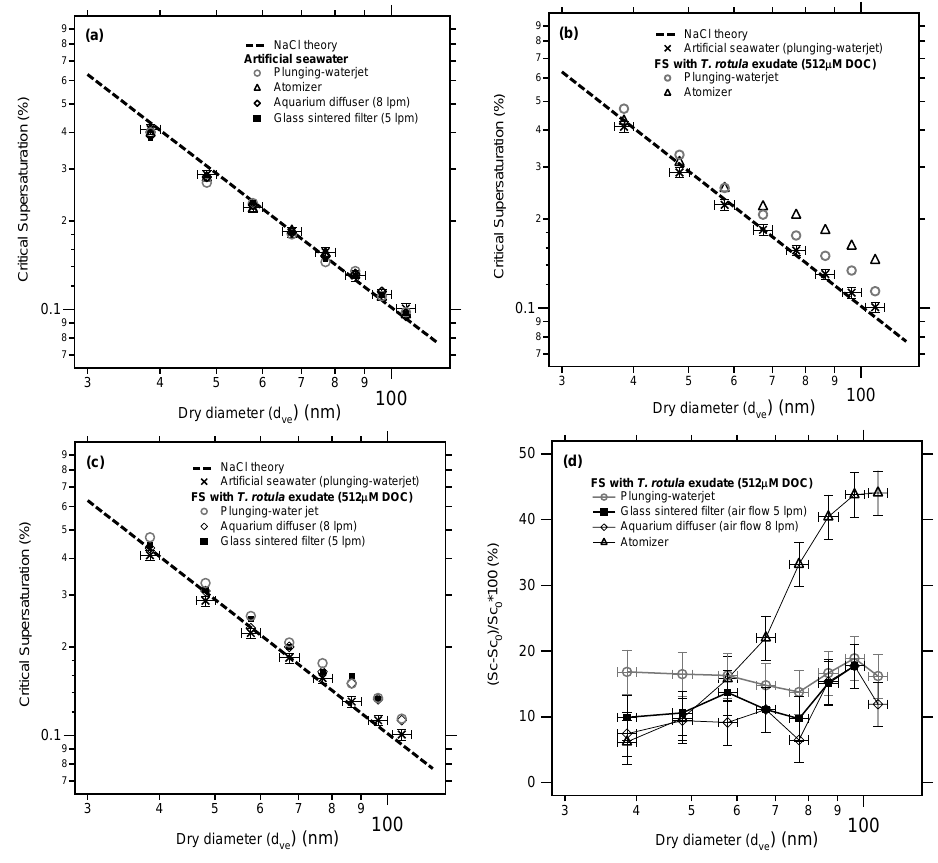
Fig. 9. Critical supersaturation as a function of particle diameter (d ve ) for the aerosol generated from (a) artificial seawater and (b) , (c) FS=filtered natural seawater enriched with Thalassiosira rotula exudate (512µM DOC concentration), for the different aerosol generation techniques. (d) Relative variation in the critical supersaturation Sc with respect to the critical supersaturation for the case without organics Sc 0 of aerosols generated from filtered natural seawater containing algal exudate. A shape factor χ =1.04 was applied to the presented data. Horizontal error bars indicate the uncertainty in the diameter selected by the DMA as function of the shape factor correction in the range from spherical ( χ =1) to cubic ( χ =1.08) shape. Vertical bars indicate the mean uncertainty in the determination of the critical supersaturation taken as ± 1 σ standard